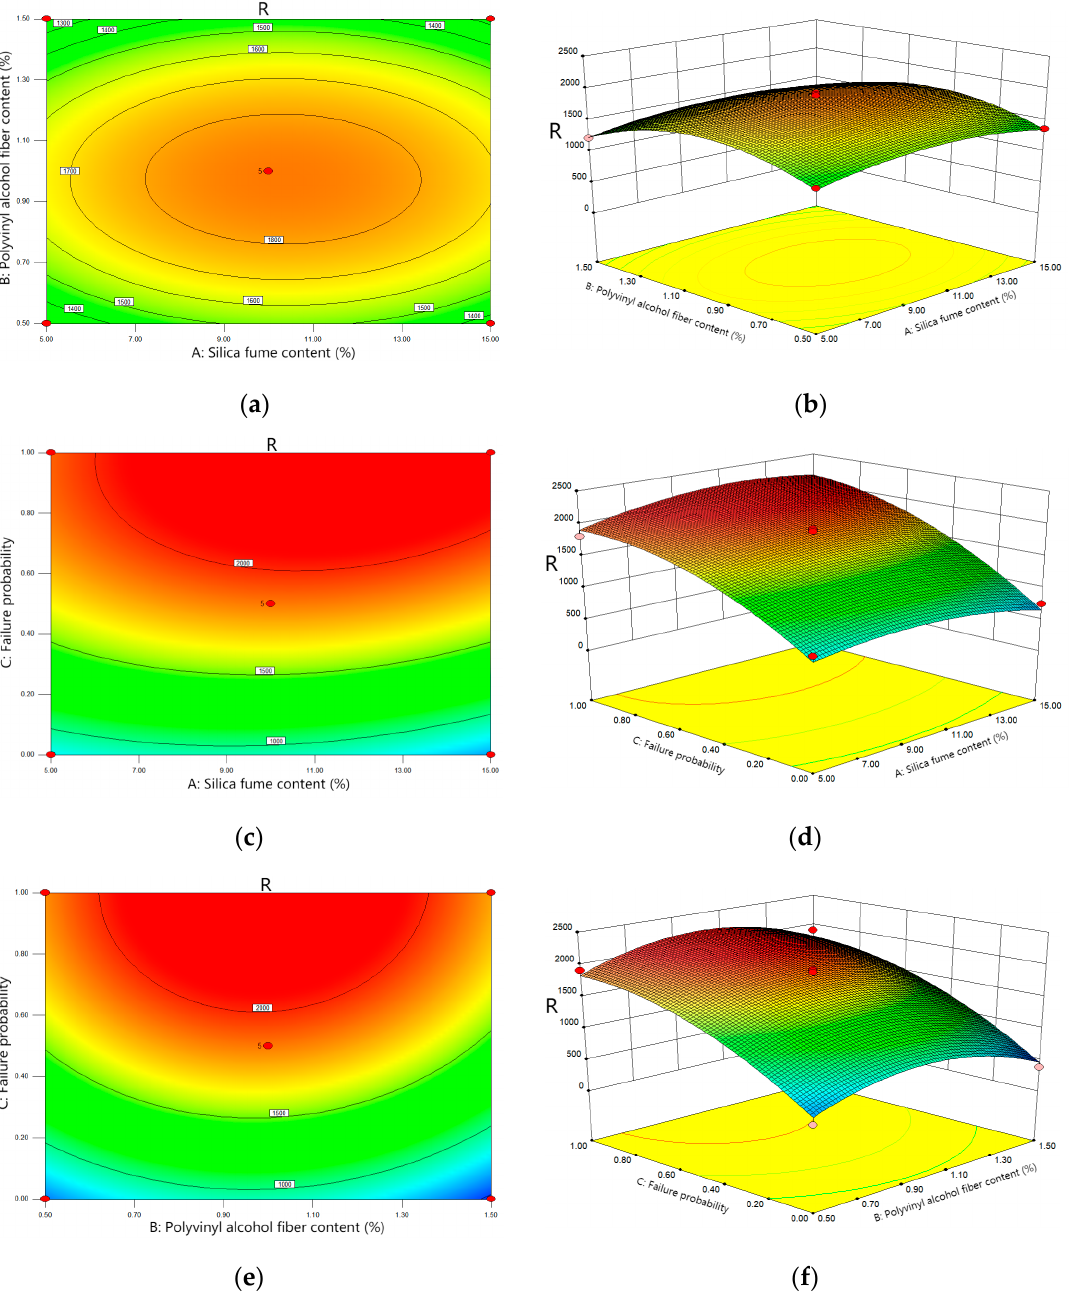
Figure 7. Effects of Factor A, B, C and their interactions on R. ( a , b ): Effects of Factor A and B and their interactions on R; ( c , d ): Effects of Factor A and C and their interactions on R; ( e , f ): Effects of Factor B and C and their interactions on R.